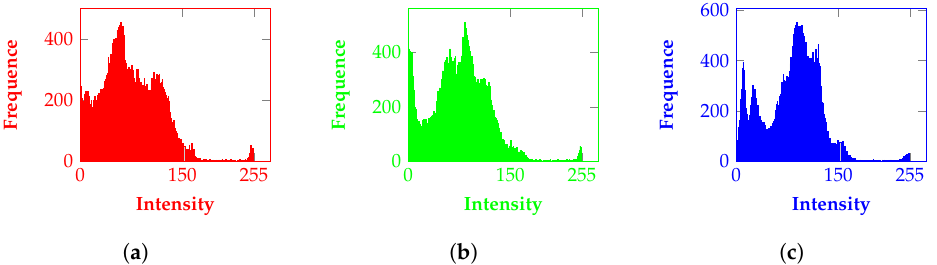
Figure 7. Histograms for RGB channels of the original image (Figure 5): ( a ) red image histogram, ( b ) green image histogram, ( c ) blue image histogram.